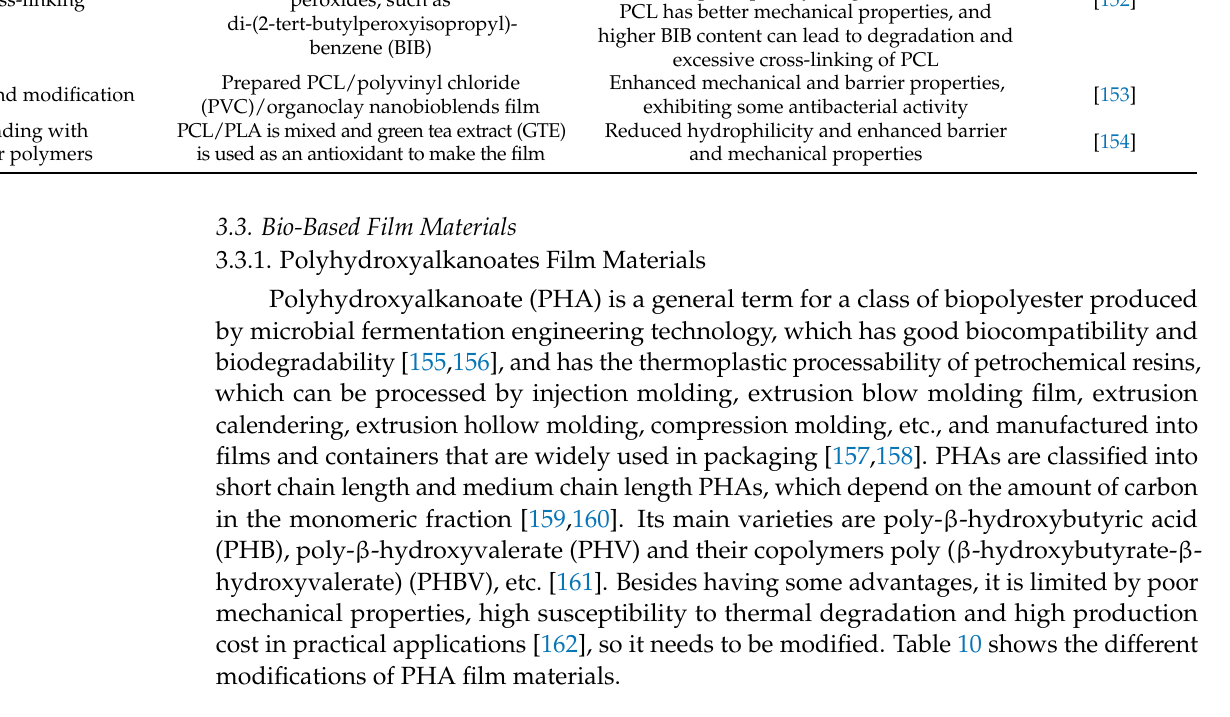
Table 10. The different modifications of PHA film